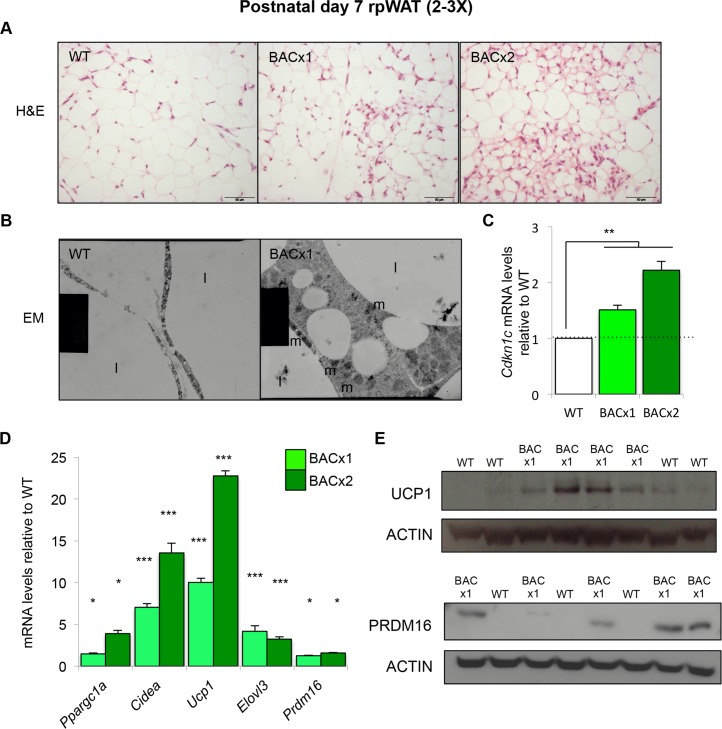
Cdkn1c promotes the browning of WAT in young mice.(A) H&E of P7 WT, BACx1 and BACx2 rpWAT (WT from line BACx1). (B) Electron micrograph of WT and BACx1 P7 rpWAT (4000X). Mitochondria indicated by m and lipid by l. (C) QPCR analysis of Cdkn1c mRNA levels in P7 rpWAT from BACx1 and BACx2 relative to wild type controls. (D) QPCR of BAT-selective genes in WT, BACx1 and BACx2 P7 rpWAT. (E) Western blot analysis of UCP1, PRDM16 and β-ACTIN in P7 rpWAT from single litters of WT and BACx1 pups. Data expressed as mean ± SEM, t test. * P <0.05; ** P <0.01; *** P <0.005.